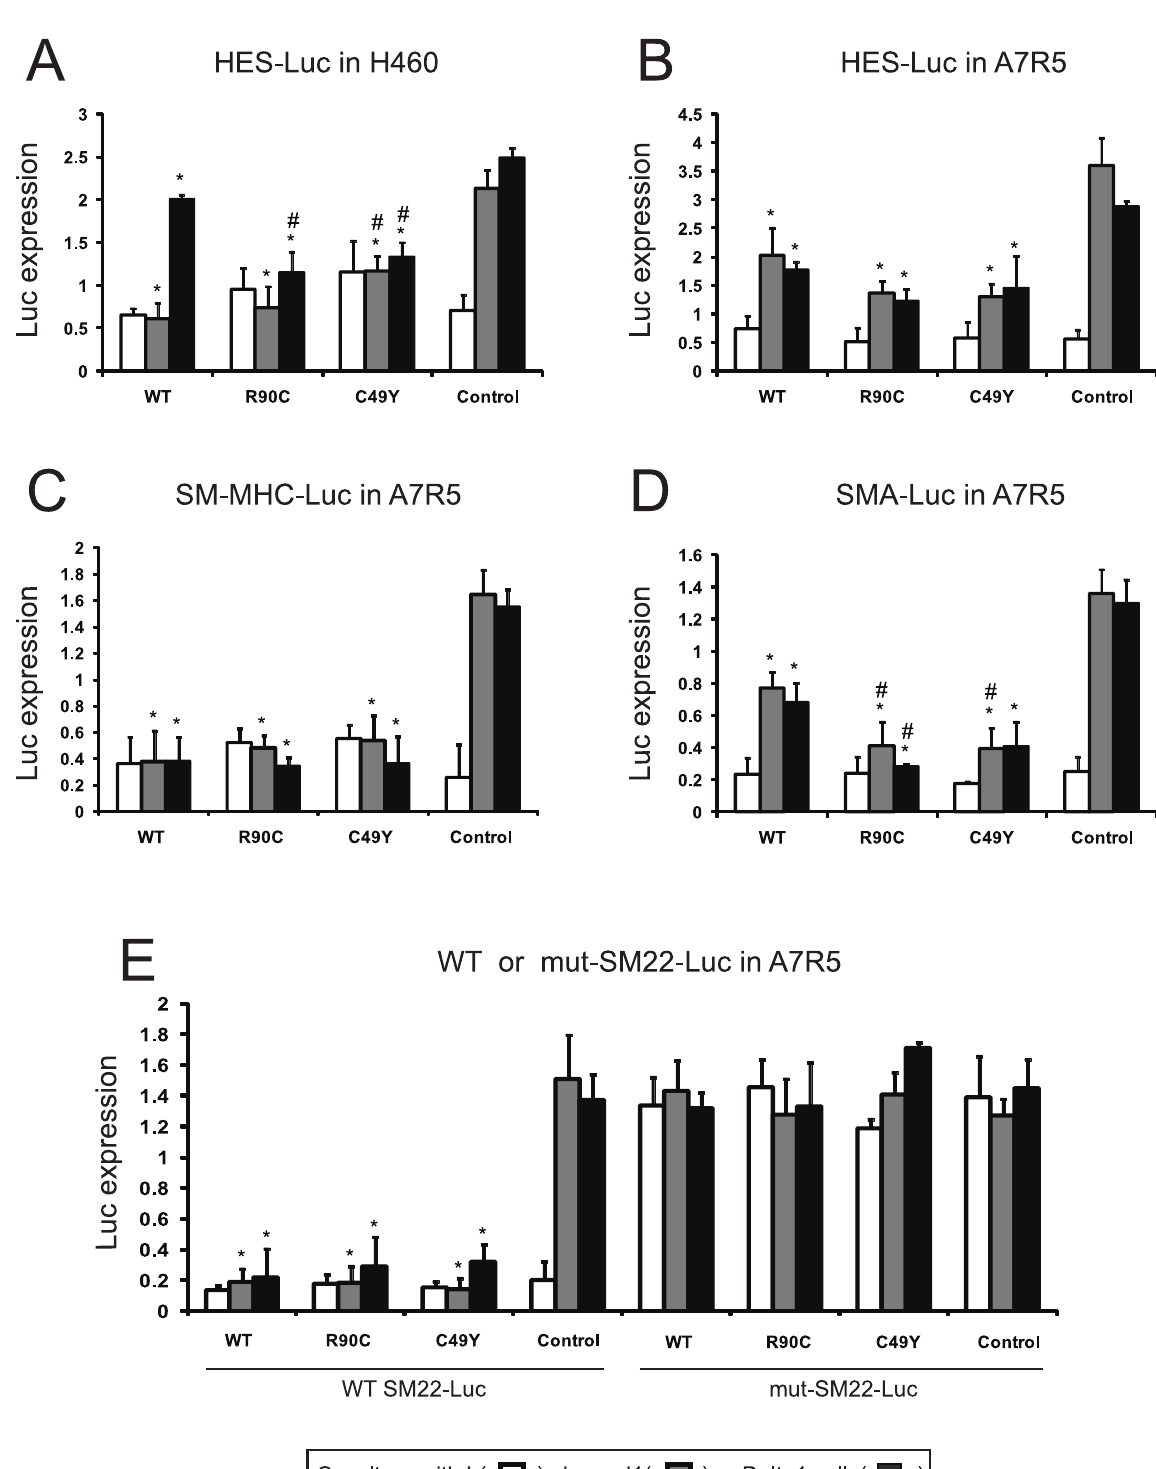
Figure 7. Inhibition of Notch mediated transcription by overexpression of full-length NOTCH3. Notch expressing cell lines H460 (A) or A7R5 (B–E) were cotranfected with luciferase reporters and either vector or full length NOTCH3 expression plasmids (n=3 replicate wells per group). In panels A and B, we show effects of NOTCH3, mutants R90C and C49Y, and control vector on ligand stimulation of HES-luciferase. The effects of cotransfection of NOTCH3 on smooth muscle actin-luciferase (C), smooth muscle MHC-luciferase (D), SM22-luciferase (E, left group) and mutant SM22-luciferase (E, right group) are shown in the lower panels. After one day, cells were overlayed with L, Jagged1, or Delta1 expressing fibroblasts to assess the effect of Notch ligand stimulation. Luciferase assays were performed after 24 hours to quantify the level of Notch signaling. All ligand